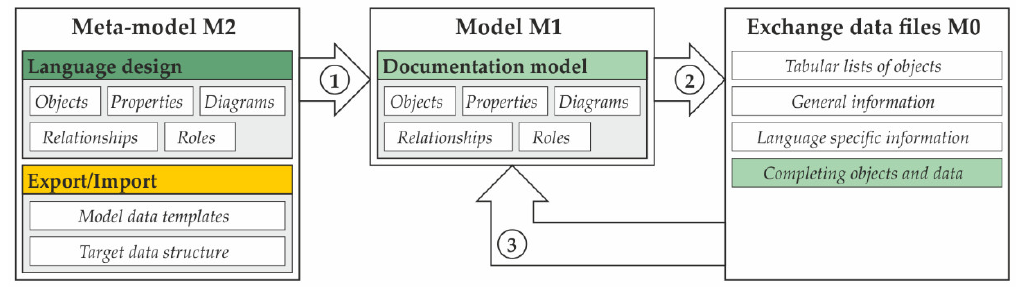
Figure 20. Specification workflow.